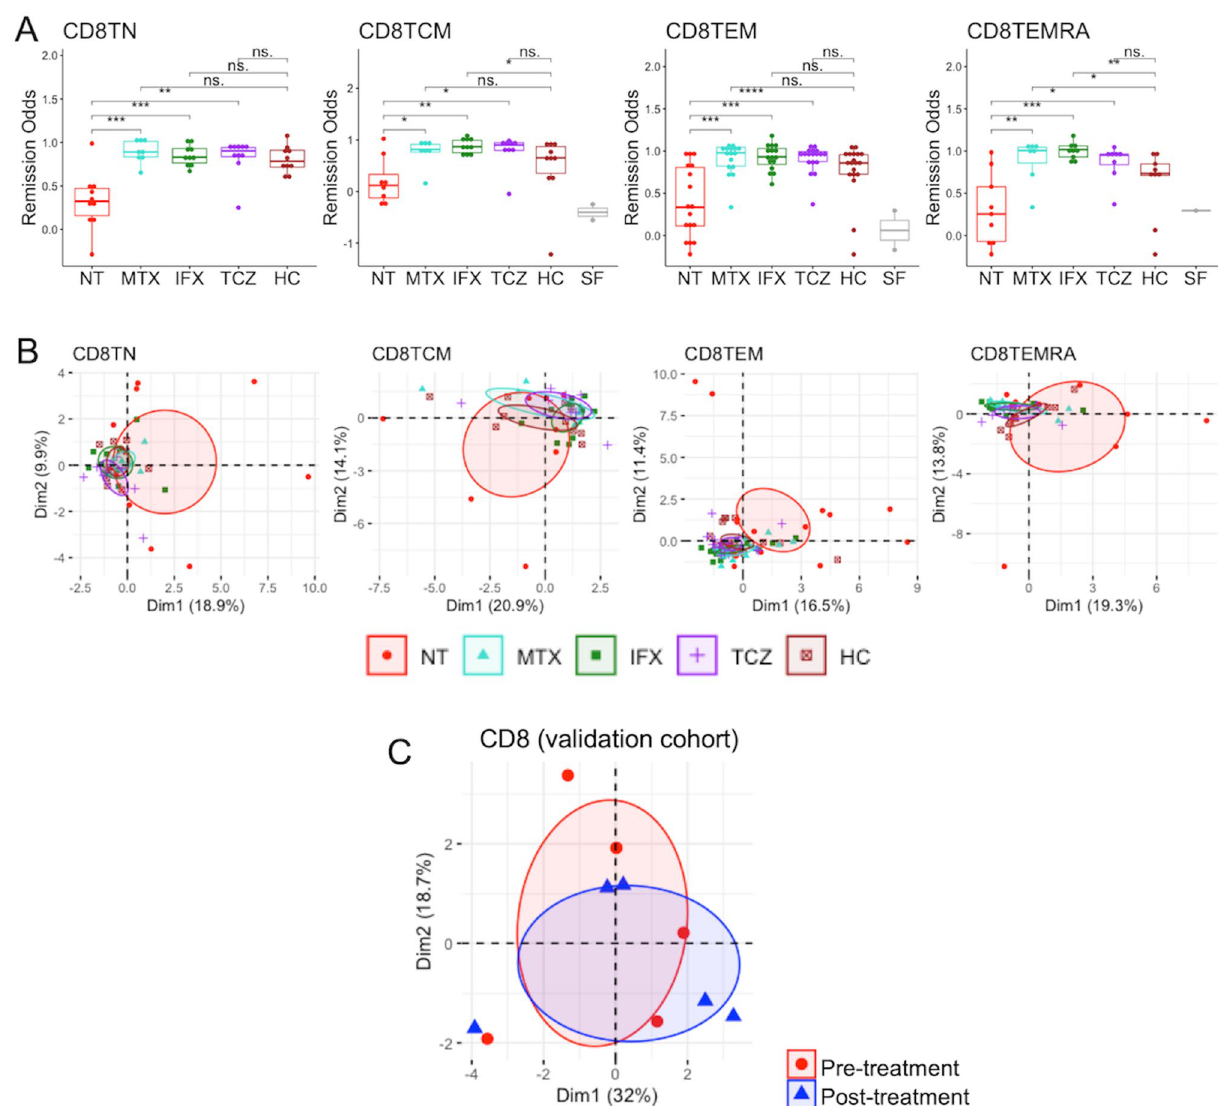
Figure 4. Remission odds and gene expression profiling of remission signature genes in CD8 + T cells. ( A ) Remission odds generated by the RA remission model. ‘*’: p < 0.05, ‘**’: p < 0.01, ‘***’: p < 0.001, ‘****’: p < 0.0001. ( B ) and ( C ) Primary component analysis using remission signature genes in the derivation cohort ( B ) and the validation cohort ( C ). The ellipse shows the 95% confidence interval of the value of principal component analysis. Patients in the validation cohort were treated by TCZ for 6 months and achieved remission after treatment. HC, healthy control; IFX, infliximab; MTX, methotrexate; RA, rheumatoid arthritis; NT, non- treatment; SF, synovial fluid; TCM, central memory T cell; TCZ, tocilizumab; TEM, effector memory T cell; TEMRA, CD45RA-positive effector memory T cell; TN, naïve T